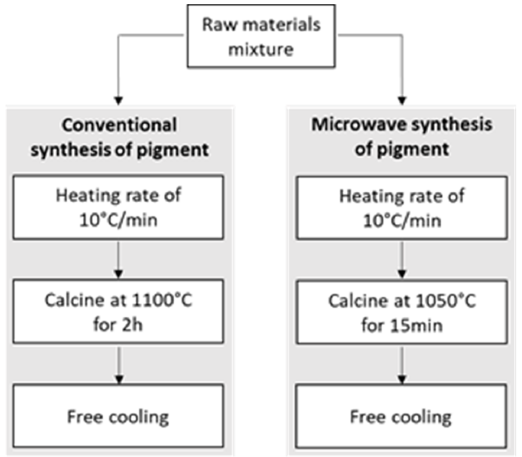
Figure 1. Procedures followed for the pigment synthesis: conventional and